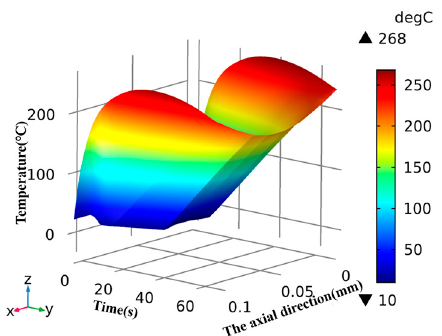
Figure 11. Temperature clouds in the axial section of the interstitial structure.